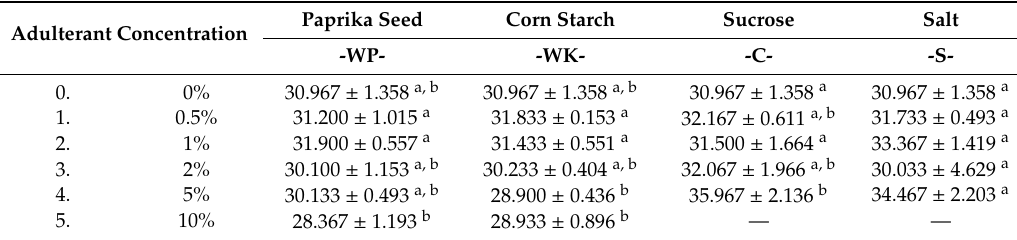
Table 2. Average soluble solid content and standard deviation of tomato pastes by adulterants and concentration levels—in ◦